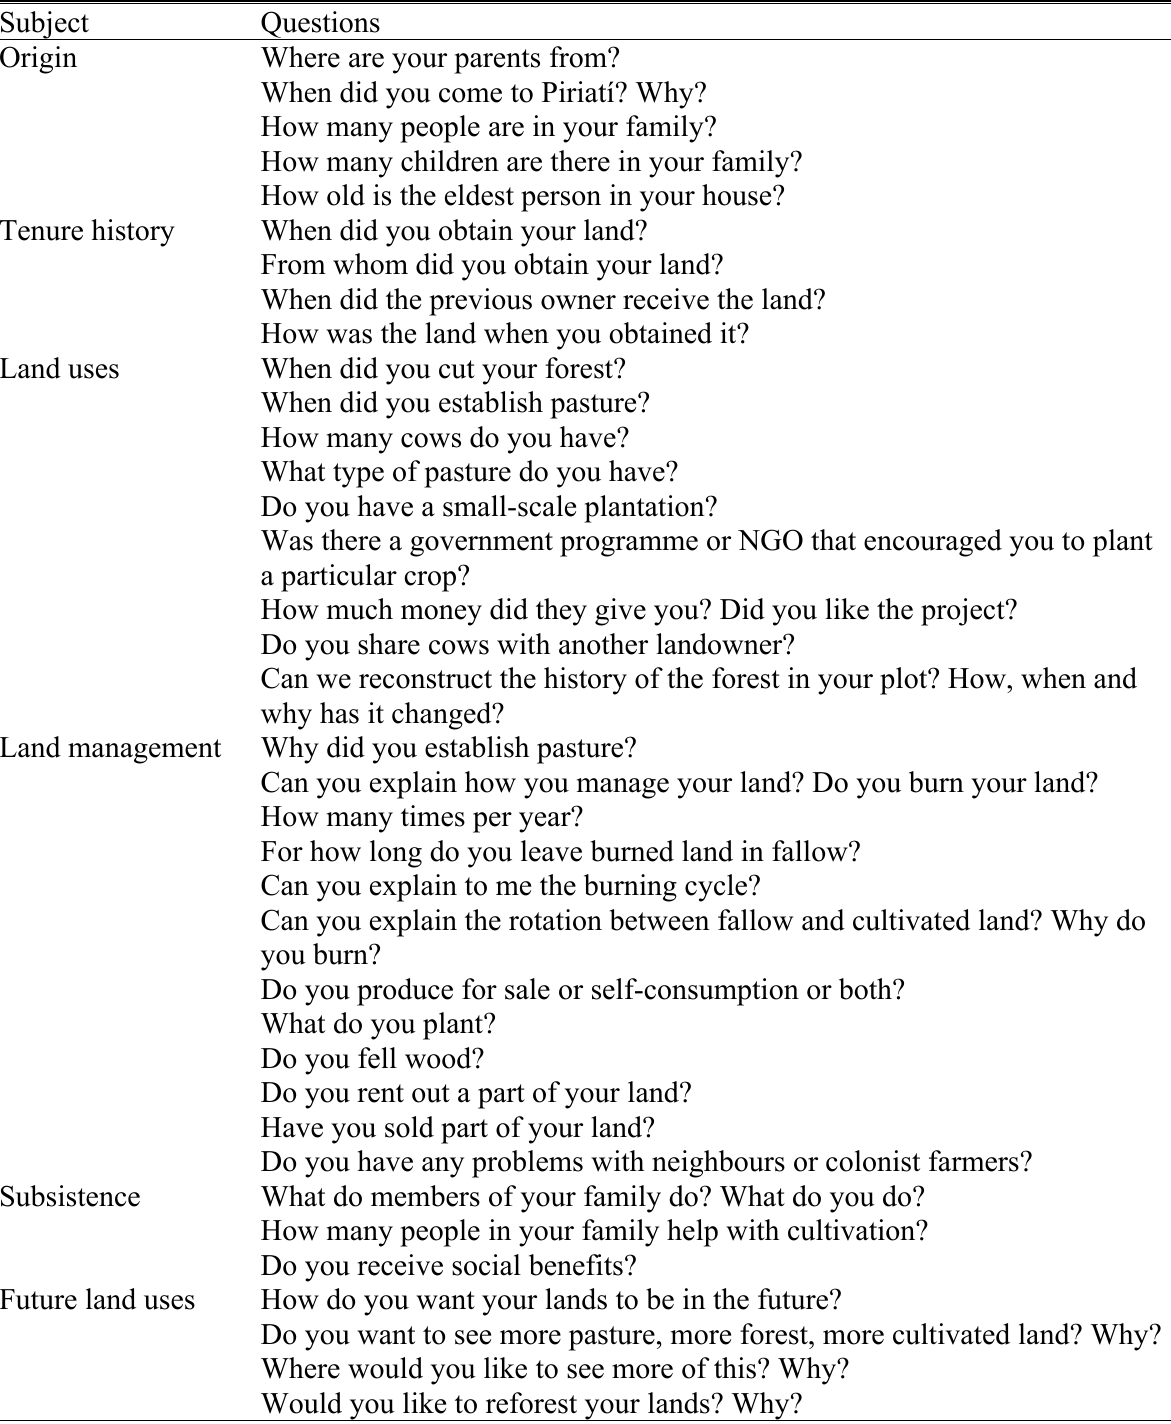
Table A1.1. Examples of questions asked during semi-structured